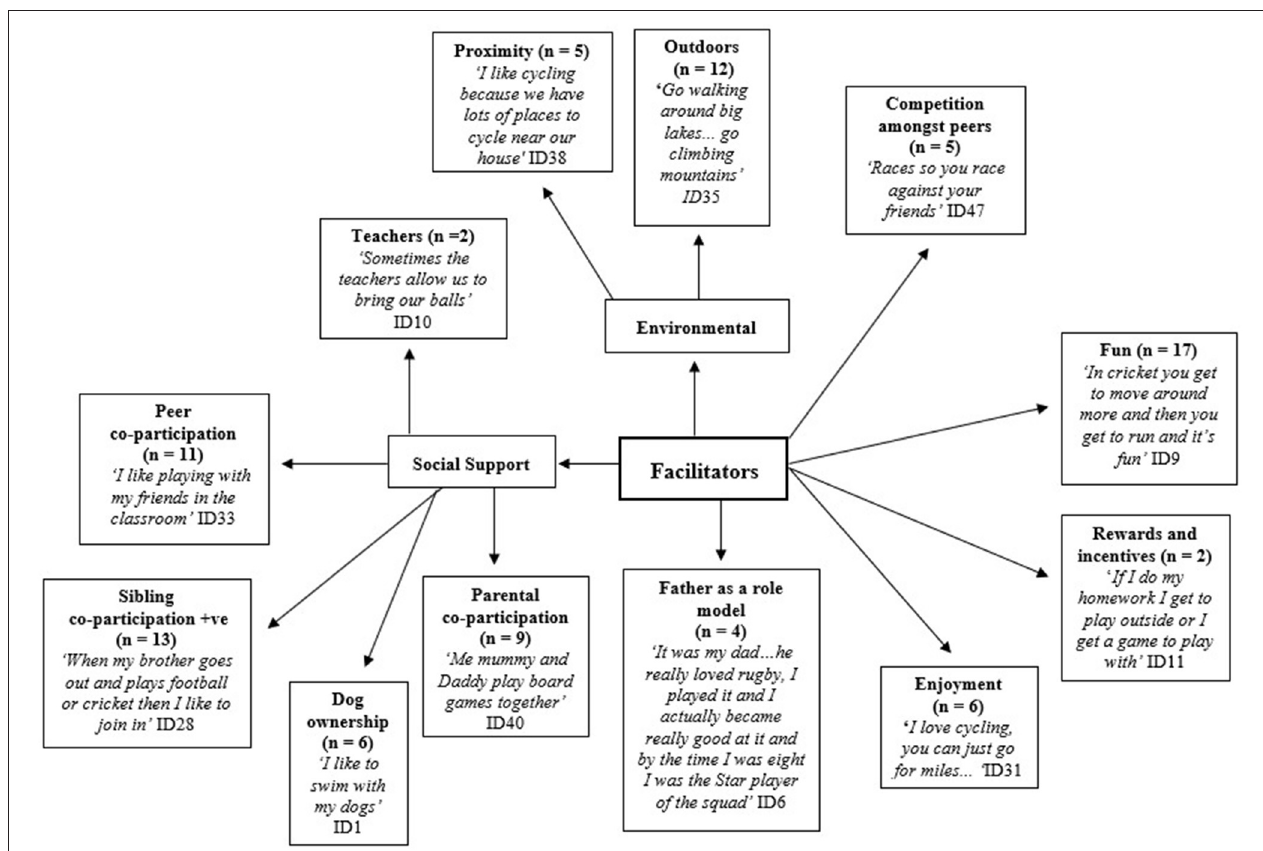
FIGURE 4 | Facilitators to children’s physical activity + ve =